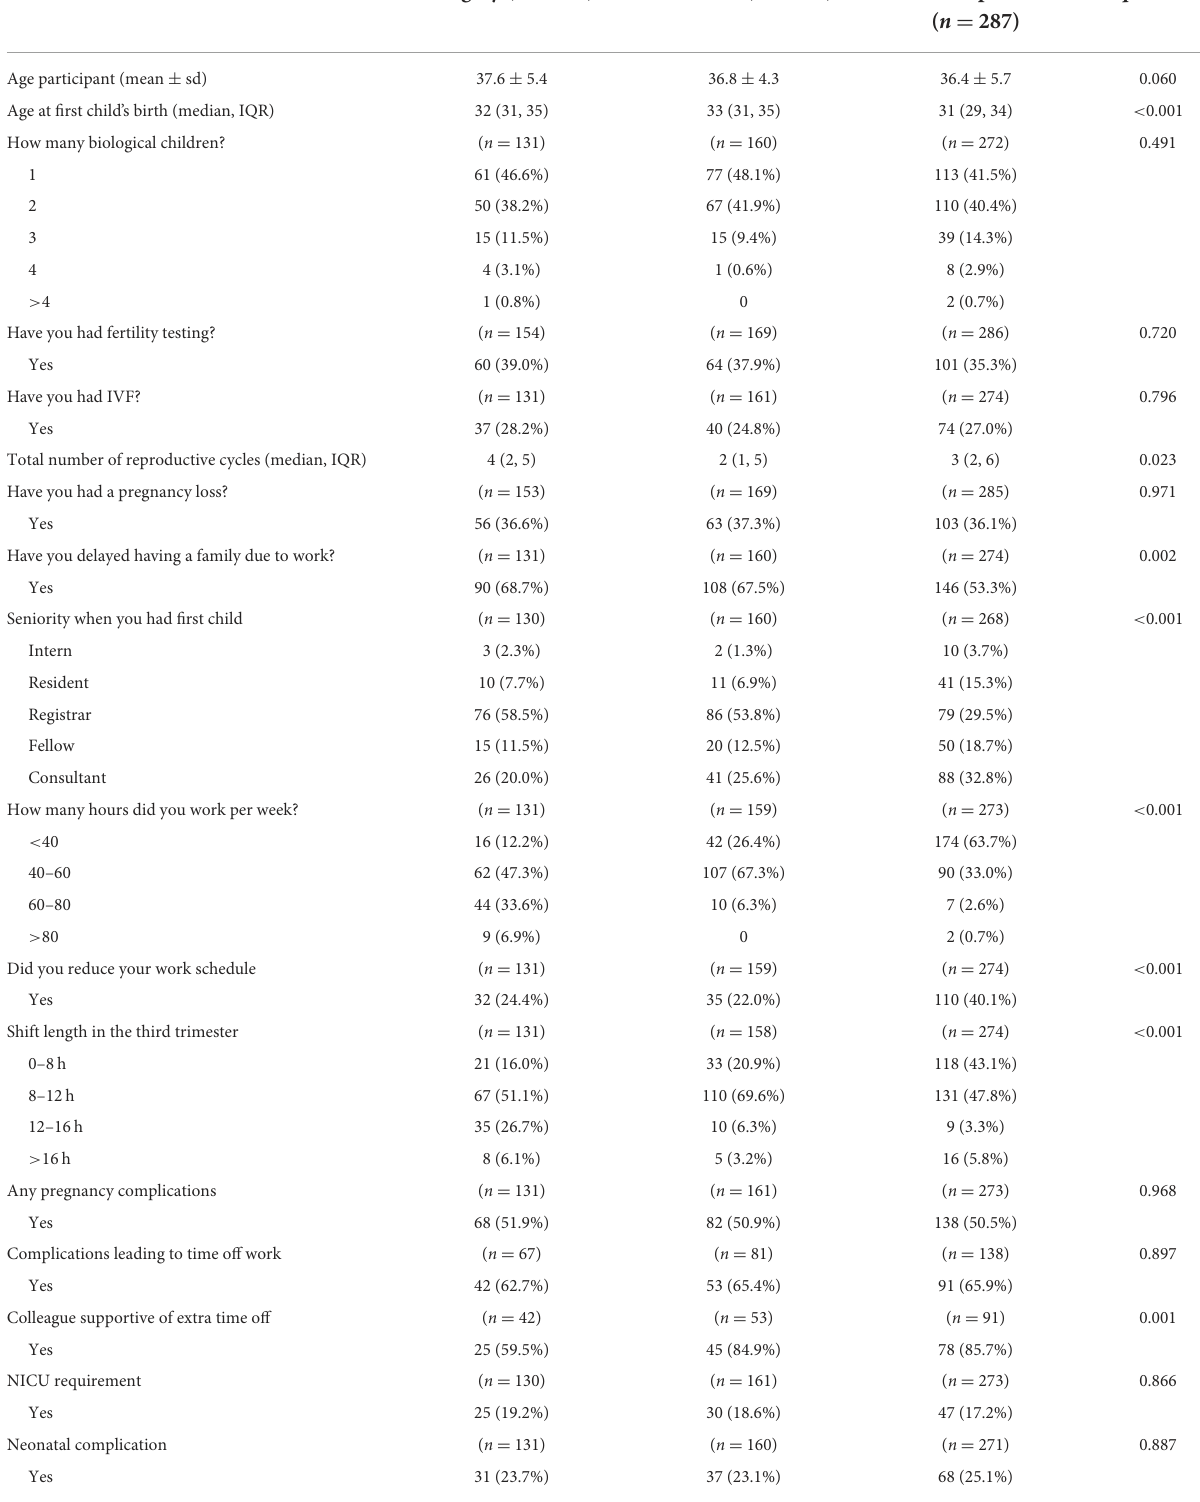
TABLE 2 Comparison between surgical, medical, and general practice sub-specialities. Surgery ( n =